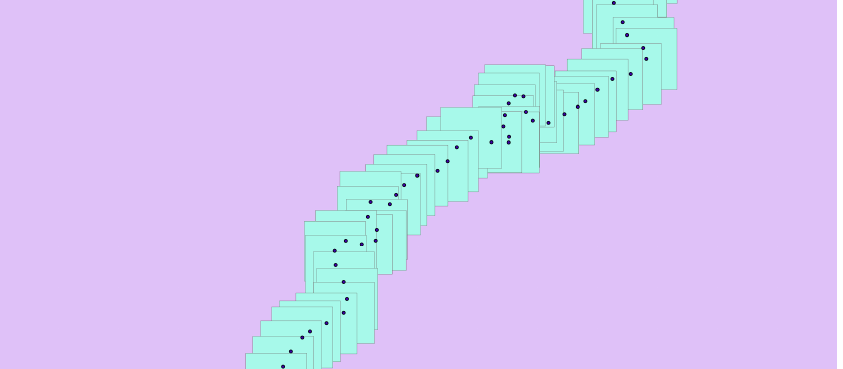
Figure 3. Detail of the location and construction for a typical river (Each dot represents a small piece of river, and the cyan bounding box of each dot represents the coverage area of each image within our dataset).